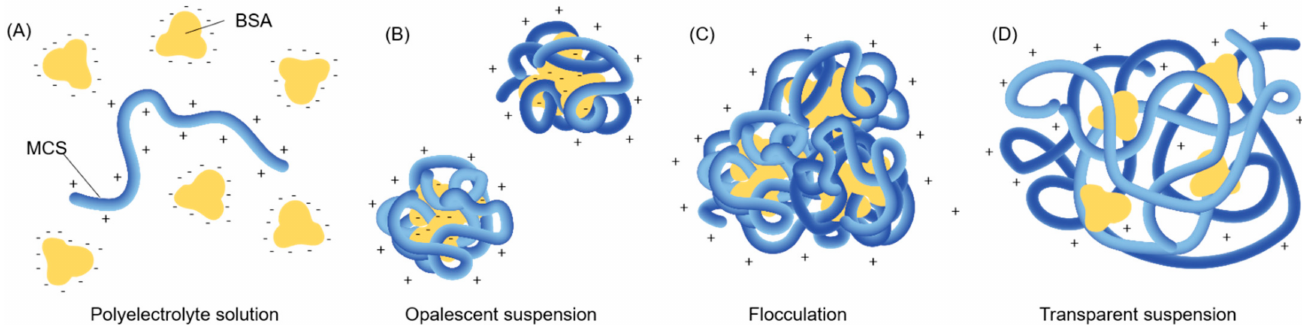
Figure 11. Illustration of complexation phenomena at various BSA:MCS ratios, at 20 ◦ C. ( A ) At low MCS mass content, a transparent polyelectrolyte solution is observed with no indication of molecular interactions detected. ( B ) When the charges of the two polymers are complementary, an opalescent suspension is observed. ( C ) As MCS starts to be in excess, flocculates start to appear and ( D ) eventually become large macroscopic aggregates resulting in a transparent suspension. Illustration based on